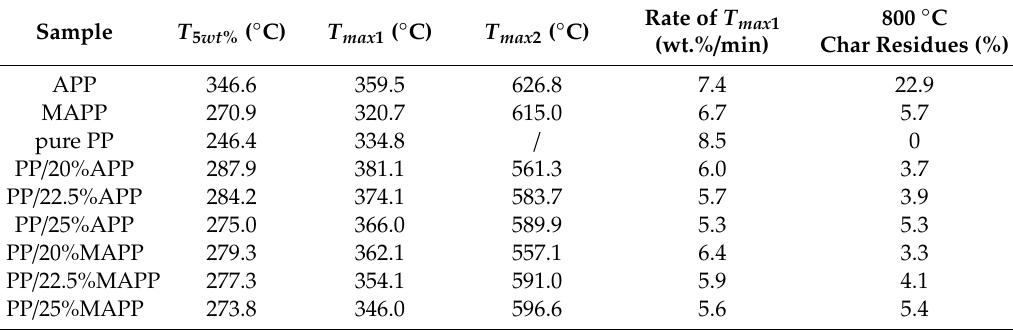
Figure 6. ( a ) TG and ( b ) DTG curves of APP and MAPP. ( c , e ) TG and ( d , f ) DTG. curves of PP and its flame-retardant blends under the air atmosphere. Table 4. Data of TGA for PP and its flame-retardant blends under air